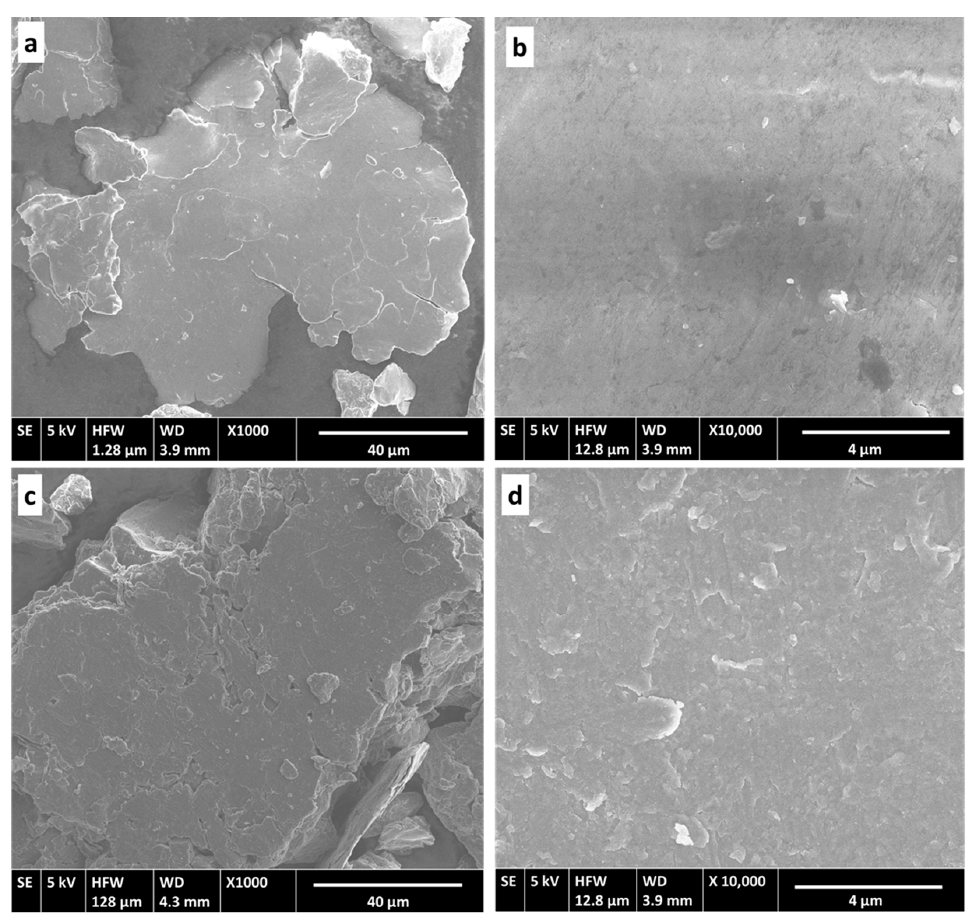
Figure 7. SEM micrographs of AA7075-MWCNT composite particles obtained after 4 h of HEBM showing the good integration of MWCNs into the 7075 matrix: ( a , b ) 0.5 wt.% MWCNTs; ( c , d ) 1 wt.% MWCNTs.